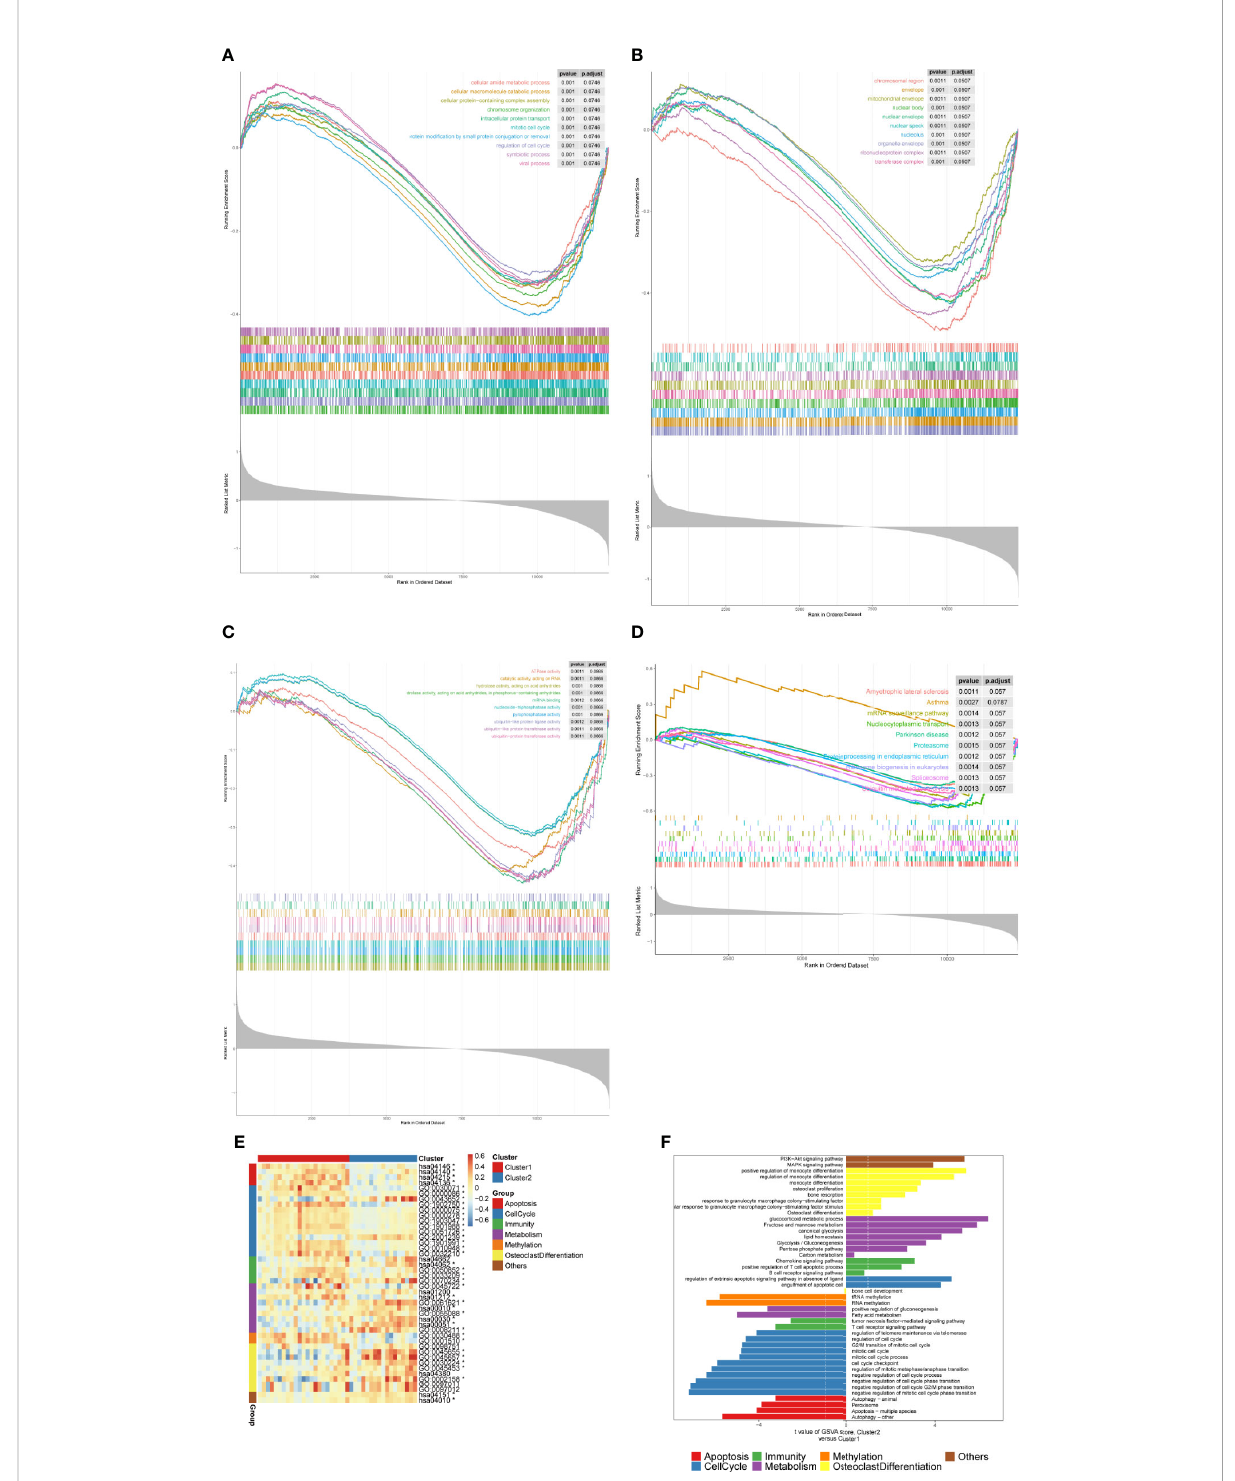
FIGURE 4 Functional analyses of the m6A-related DEGs. (A – D) The GSEA curves showing the GO (BP, CC, and MF) and KEGG pathways between two m6A-related subclusters. (E, F) Heatmap and bar charts showing the speci fi c signaling pathways in two m6A-related